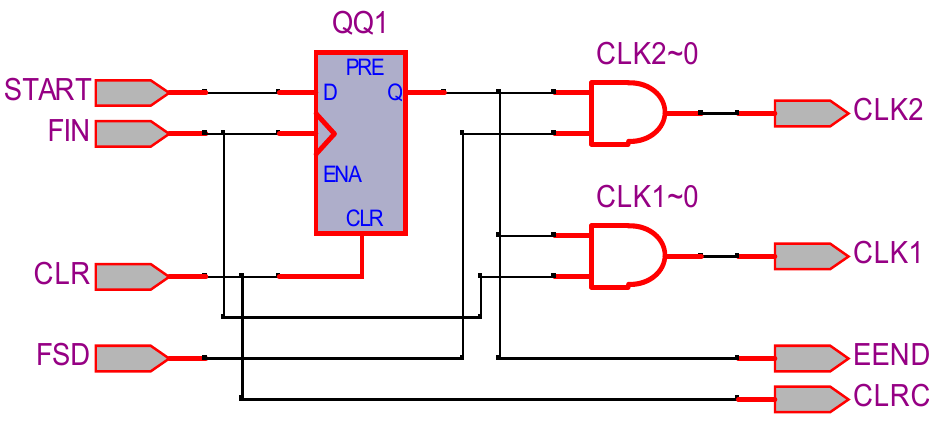
Figure 4. Clock control circuit of frequency measurement and period